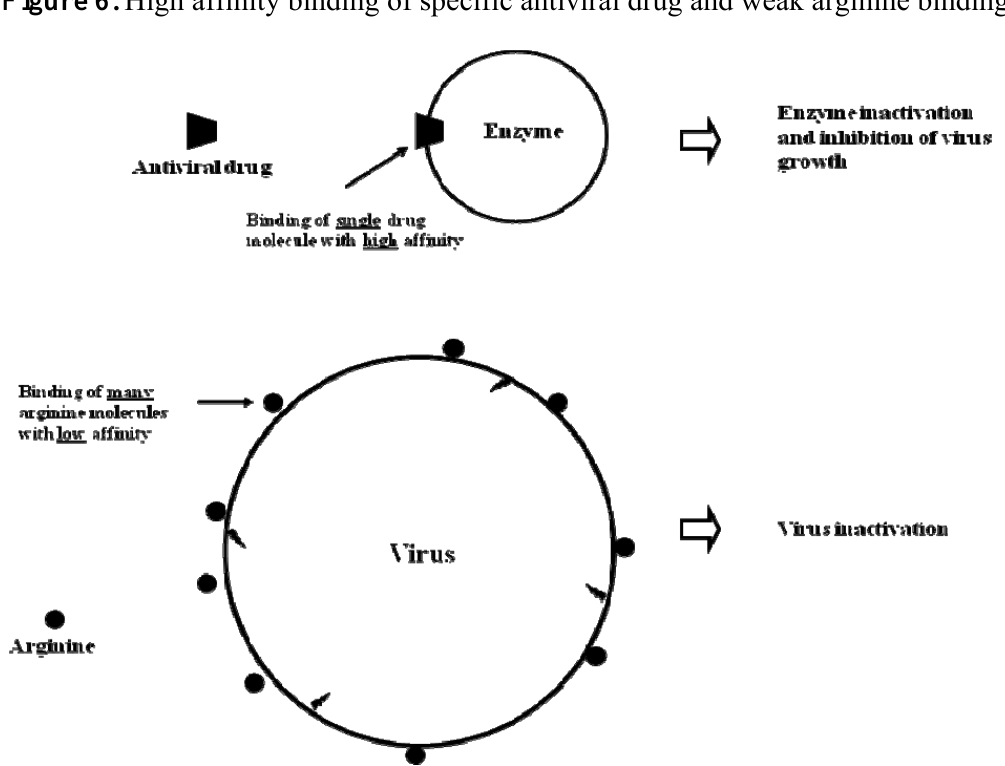
Figure 6. High affinity binding of specific antiviral drug and weak arginine